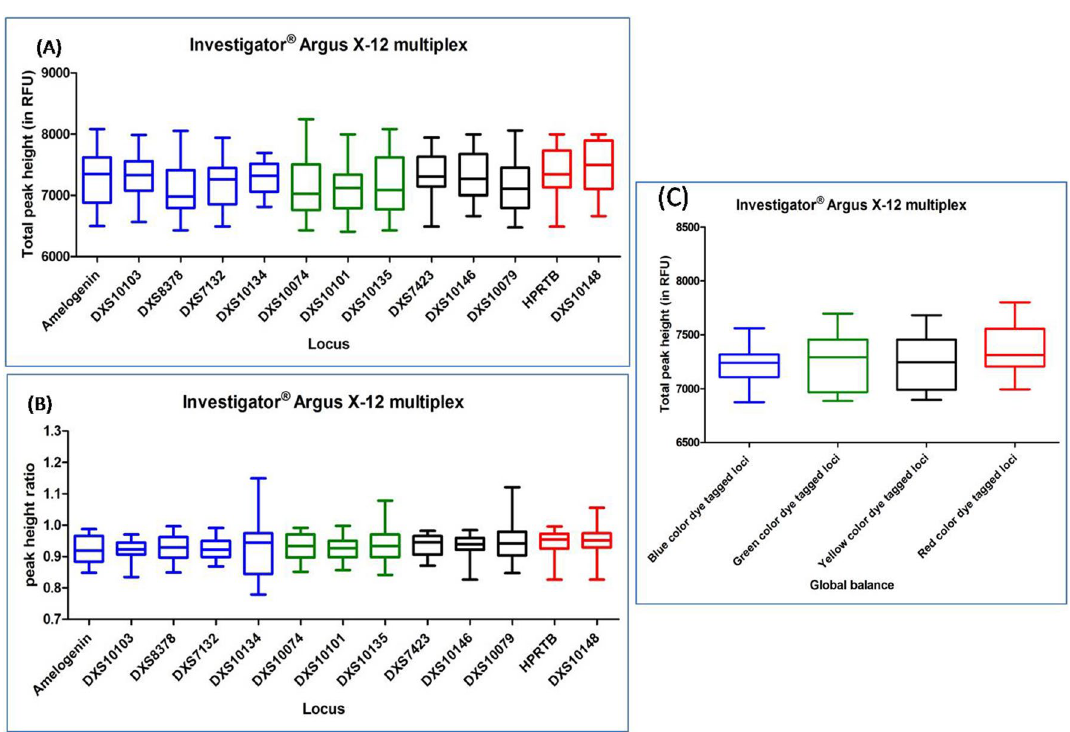
Figure 14. Quality assessment of DNA profile by Dunn’s multiple comparison test for the INVESTIGATOR ARGUS X-12 MULTIPLEX KIT ( A ) Total peak height ( B ) Peak height ratio ( C ) Global